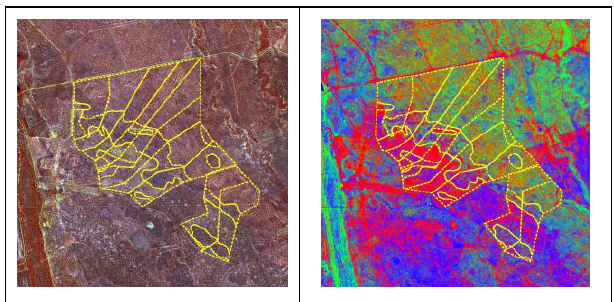
Figure 3. Example of fractional cover image produced from Sentinel-2 imagery over the Wambiana grazing trials (red: bare ground, green: green vegetation, blue: non-green